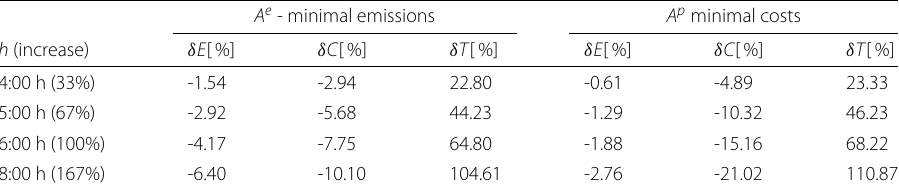
Table 2 Mean relative CO 2 ( δ E ) and cost differences ( δ C ) for charging algorithm a and different temporal flexibility h compared to immediate charging A